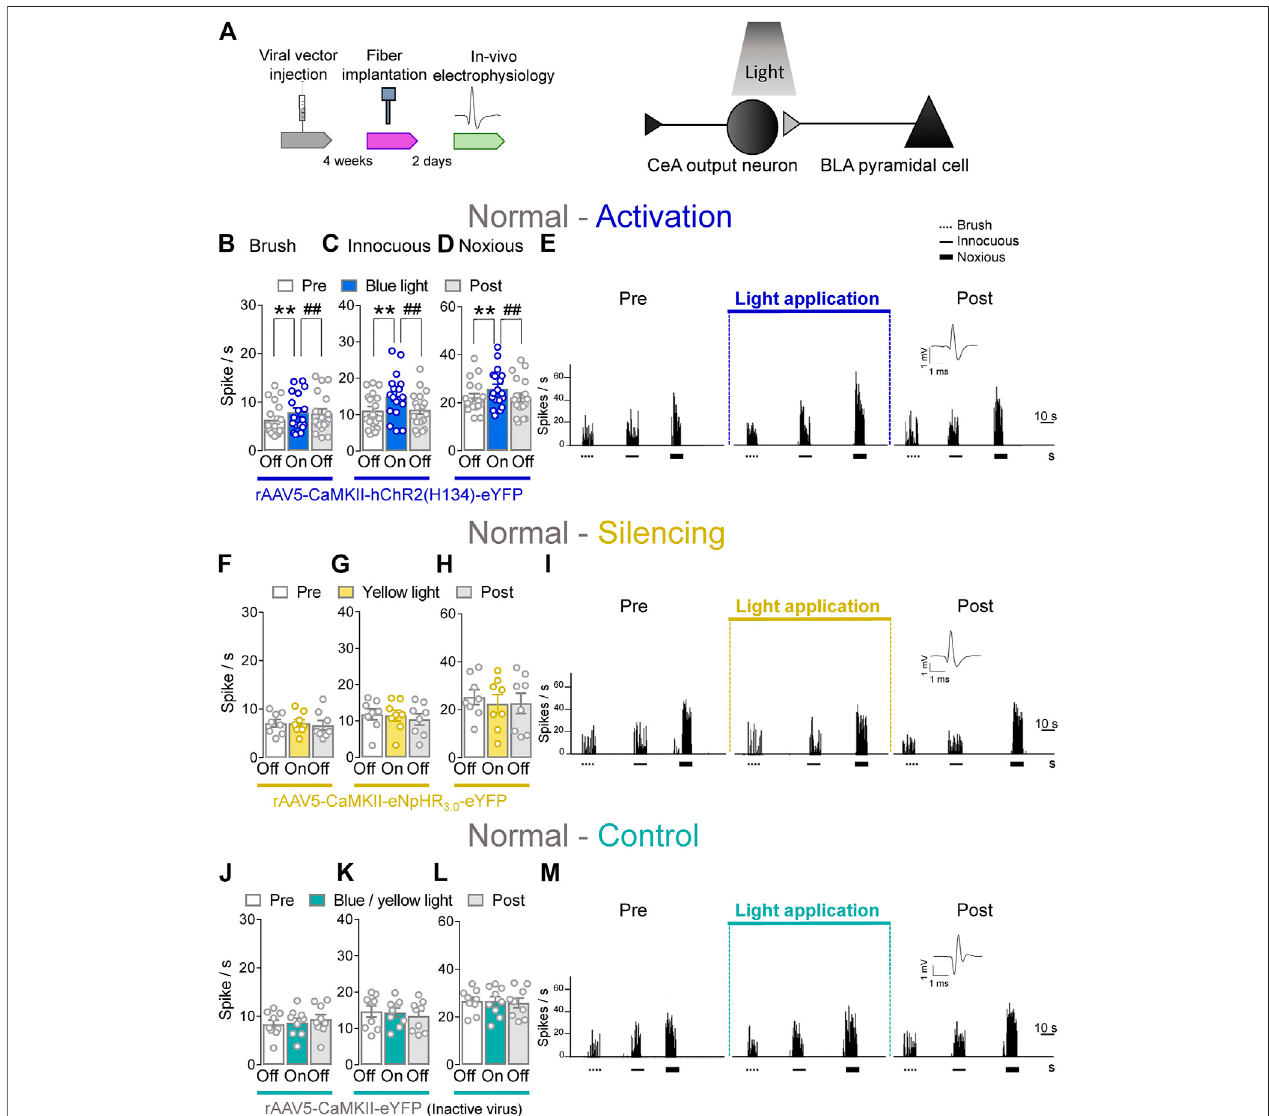
FIGURE 2 | Optogenetic activation of BLA axon terminals in the CeA under normal condition increases evoked activity of spinal cord neurons. (A) Experimental design. Neuronal WDRactivity ( n (cid:1) 18) evoked by brushing theskin (B) and innocuous (C) and noxious (D) compression ofthe left knee jointwas signi fi cantly enhanced by optical activation of ChR2 on the BLA – CeA terminals with blue (473 nm) light ( “ On ” , 20 Hz, 5 mW, 5 – 10 min) compared to no light ( “ Off ” ) values in normal naive rats. (E) Peristimulus time histograms (500 ms bin size) show recordings of an individual WDR neuron before, during and after blue (473 nm) light application (20 Hz, 5 mW, 5 – 10 min) in a normal naïve rat. Bar histograms show means ± SEM. **, ## p < 0.01, repeated measures one-way ANOVA with Bonferroni posthoc tests (F – H) Same display as (B – D) but for BLA – CeA terminal inhibition with yellow (590 nm) light ( “ On ” ) to activate eNpHR 3.0 ( n (cid:1) 8). (I) Same display as (E) but for BLA – CeA terminalsilencing. (J – L) Samedisplayas (B – D) butinYFP – expressingcontrolratswitheitherblue(473 nm, n (cid:1) 4)oryellow(590 nm, n (cid:1) 5)light( “ On ” )application( n (cid:1) 9). (M) Same display as (E) but in a YFP – expressing control